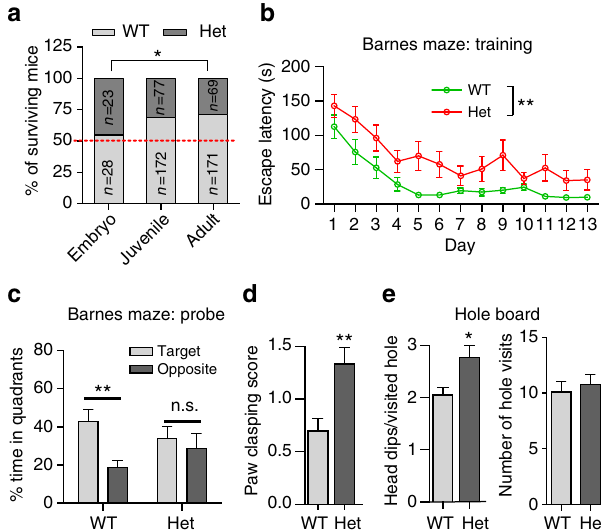
Fig. 1 Mef2c -het mice display MCHS-like phenotypes. a Mef2c -het mice die prematurely. The number of Mef2c -het compared to WT mice was nearly equal at E18, but ~45% that of WT by adulthood (~3 months) (* P < 0.05 by χ 2 ). b , c Impaired spatial learned and memory in the Barnes maze of Mef2c - het mice during training ( b ) and on subsequent probe tests ( c ). d , e Increased paw clasping ( d ) and repetitive head dipping ( e ) of Mef2c -het mice in hole-board exploration. Data are mean ± s.e.m.; n = 9 – 11 mice per genotype in b , c , and e ; n = 30 (WT) and 21 (het) in d ; * P < 0.05, ** P < 0.01 by Student ’ s t test ( c – e ) or ANOVA ( b ). n.s. not signi fi